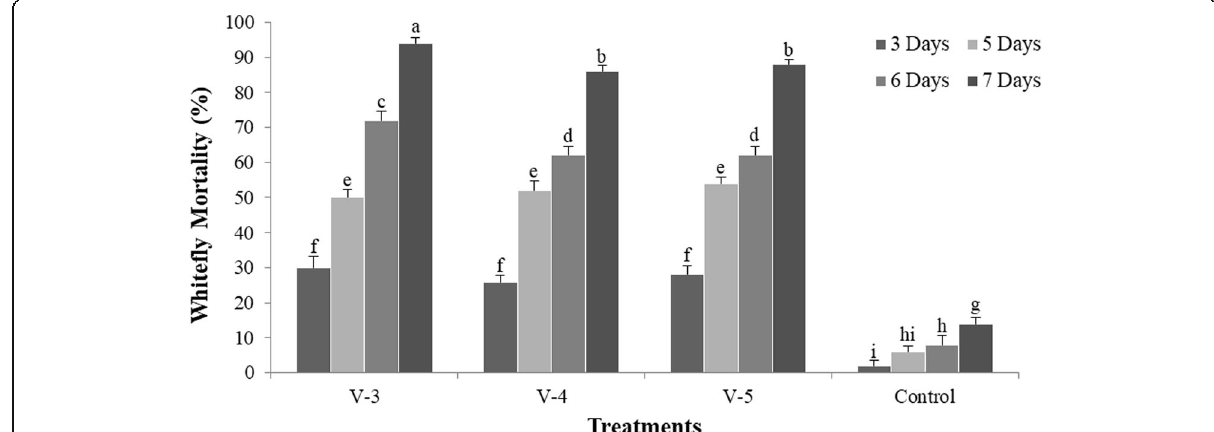
Fig. 2 Mean mortality (%) of Bemisia tabaci noted at different time intervals (3rd, 5th, 6th, and 7th) for filtrate bioassays executed with different strains of Lecanicillium lecanii (V-3, V-4, and V-5). The columns show mean percent mortality ± SE (n = 5). Treatment columns bearing different alphabets are significantly different from other treatments (least significant difference (LSD test at p = 0.05). See Table 2